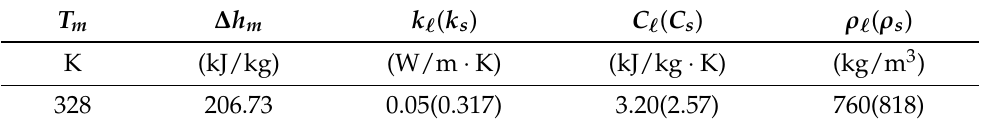
Table 2. Thermodynamic properties and liquid–solid saturation values of paraffin wax estimated through the experimental measurements and minimization of the quadratic error defined in this work.